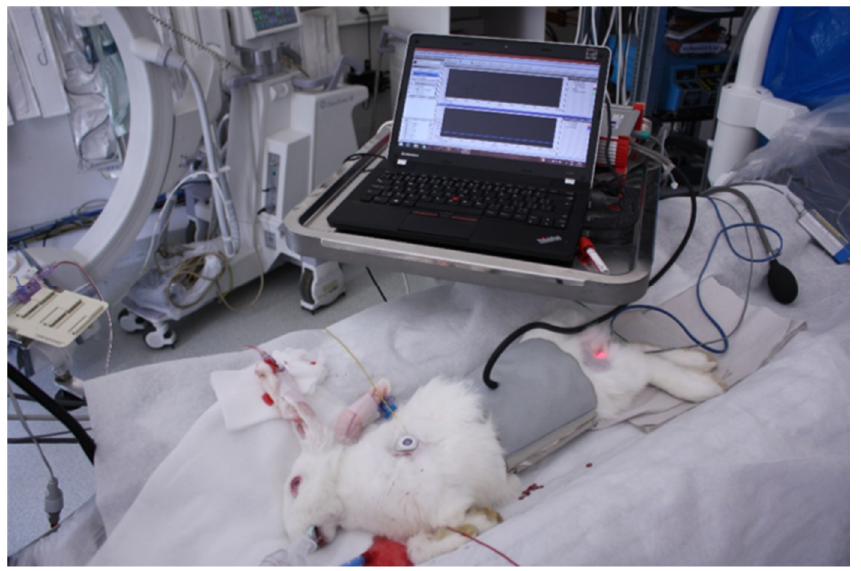
Figure 8. An animal experiment in the lab. The animal model body is in a gray cuff to monitor the chest excursions and PC measuring apparatus.